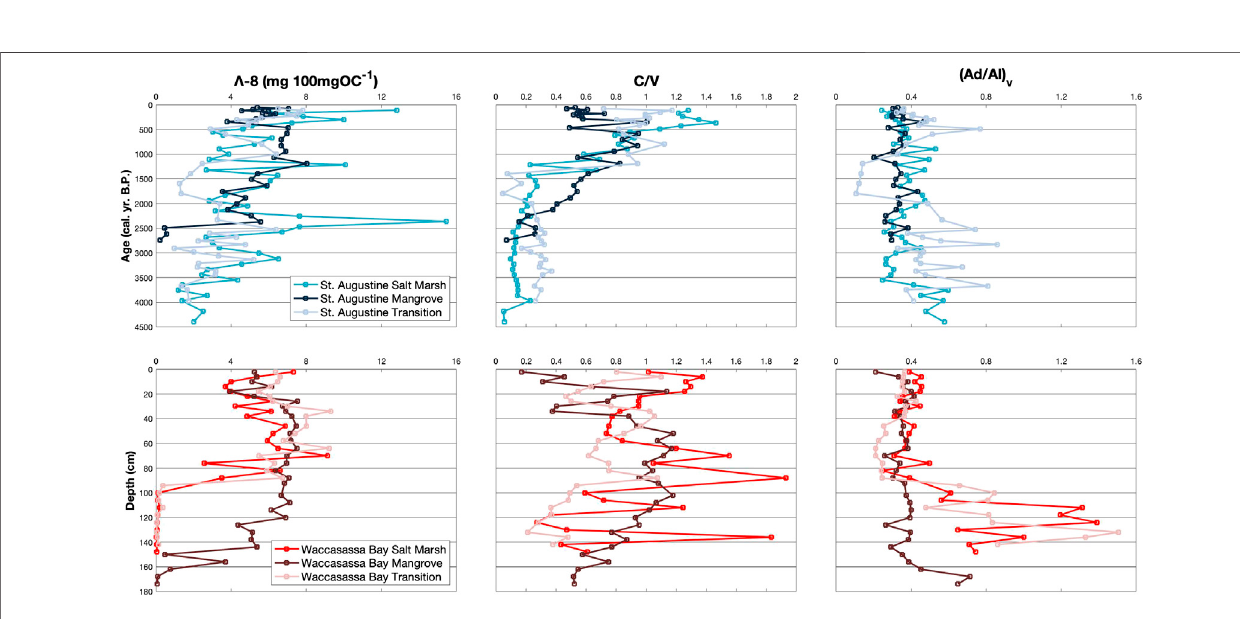
Frontiers in Earth Science |